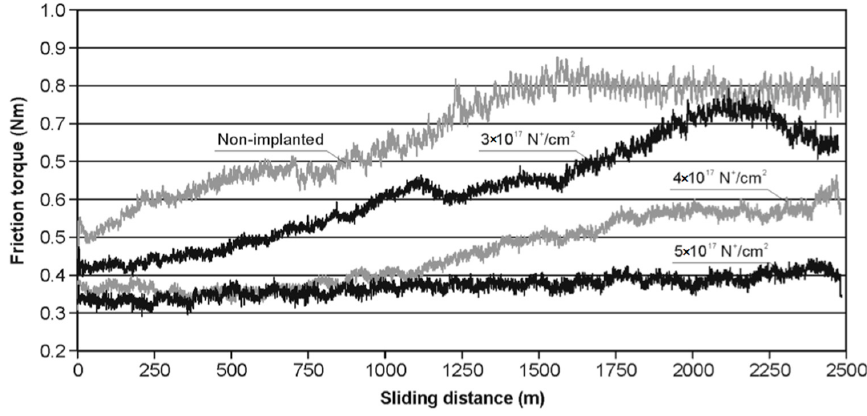
Figure 7. Friction torque as a function of friction distance for the guide pads.